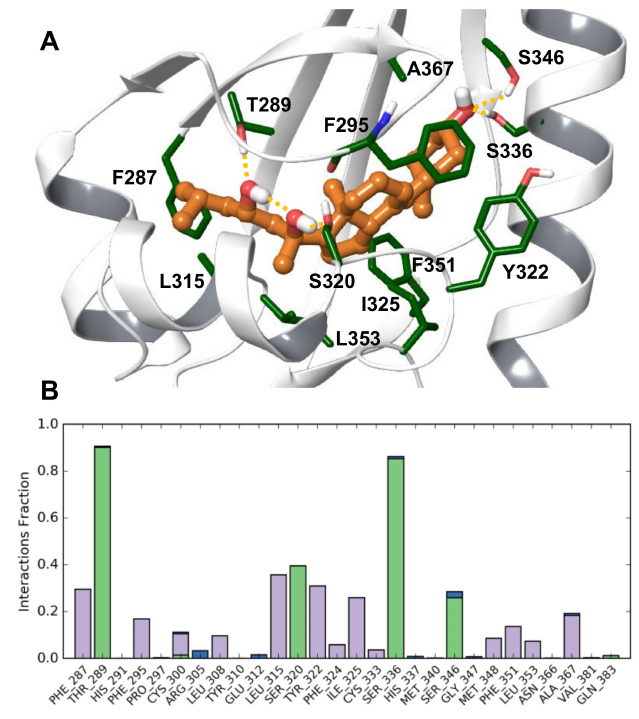
Figure 8. ( A ) The proposed binding model 20 S ,23 S (OH) 2 D3 at human AhR. ( A ) Representative simulation snapshot at 230 ns. Shown residues contribute to the binding of the ligand over simulation time. ( B ) Fraction of simulation time during which interactions are present with each AhR residue, averaged over 130–250 ns of the simulation production run.